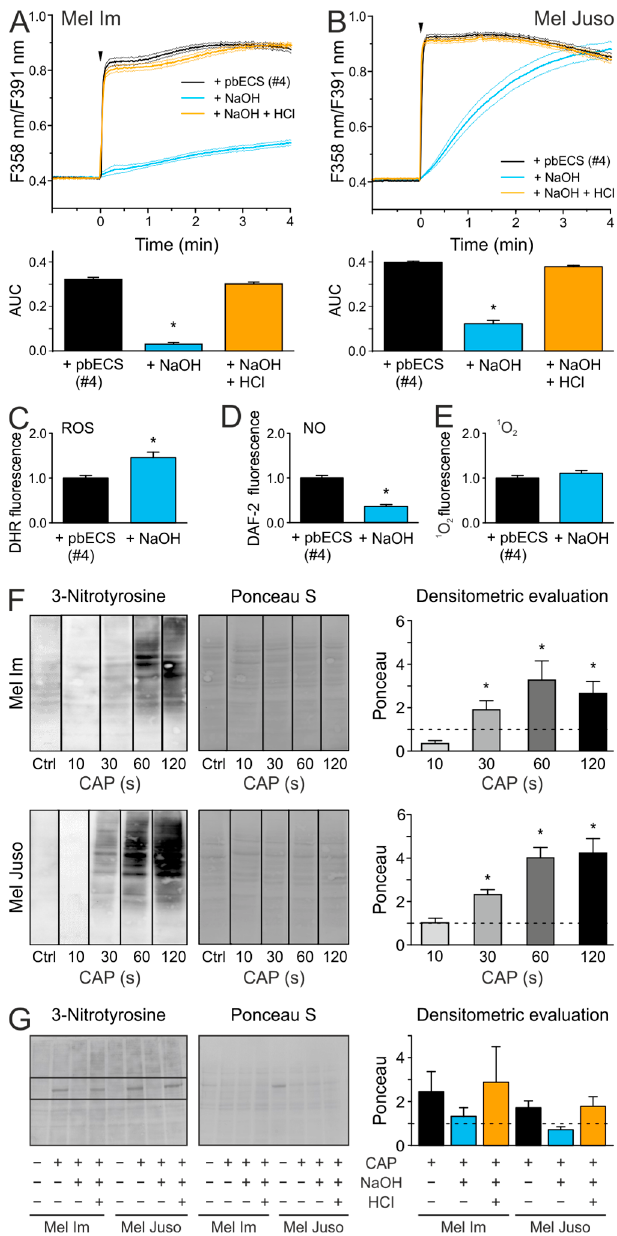
Figure 4. The stability of CAP-induced reactive species is pH dependent and NO is involved in protein nitration by CAP at an acidic pH. The acidic pH (5.8) of pbECS (#4) after CAP treatment was titrated to about 7.4 by NaOH (1 M) or further titrated back to a pH of about 6 using HCl (1 M). ( A , B ) PbECS (#4; 7 × 20 µ L) treated with 120 s CAP was applied (arrow) to Mel Im (( A ), n = 377–442) and Mel Juso (( B ), n = 326–390) cells. ( C – E) Fluorescence spectroscopic analysis of CAP-produced species in pbECS (#4; 7 × 20 µ L) after pH titration, by using DHR 123 ( C ), (10 µ M), DAF-2 ( D ), (10 µ M), and Singlet Oxygen Sensor Green Reagent (E), (10 µ M). The data are normalized to the respective controls (without pH titration). ( F , G ) Western Blot analysis of CAP-induced protein nitration after direct ( F ) and indirect ( G ) CAP-treatment of Mel Im and Mel Juso cells. Densitometric evaluation is shown as mean ± SEM. The pixel intensity of each lane is shown in Table S1.